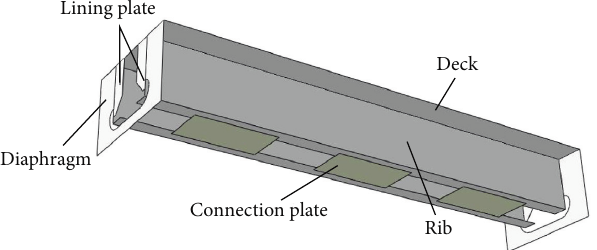
Figure 1: New orthotropic steel bridge deck